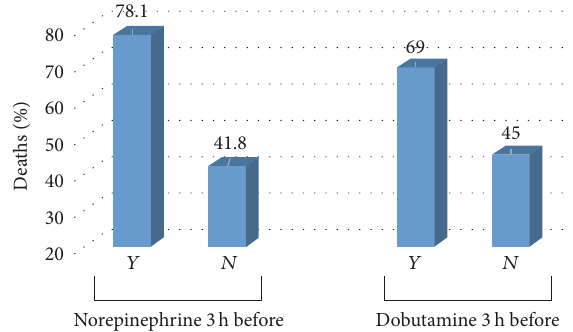
Figure 2: Mortality in patients with AF, according to the use of vasoactive drugs (VAD) immediately before the